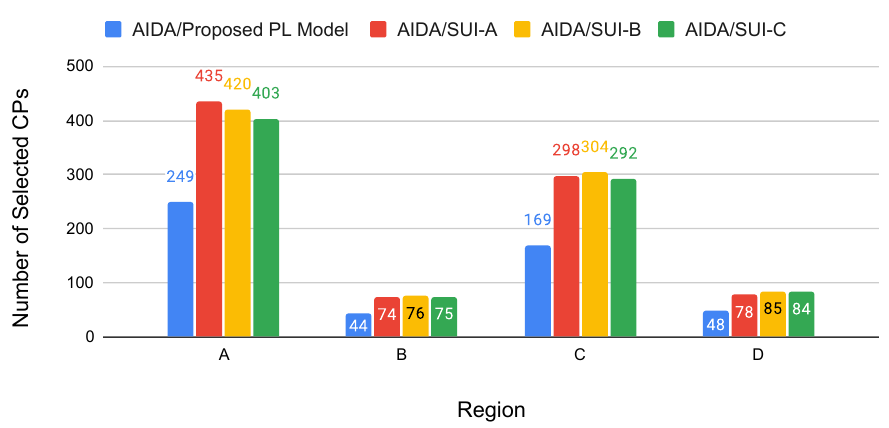
Figure 10. Number of CPs selected by the AIDA method using its original path loss model (AIDA/proposed PL model) compared to the values selected by the AIDA method using the Erceg- SUI path loss model for the terrain Category A (AIDA/SUI–A), Category B (AIDA/SUI–B), and Category C (AIDA/SUI–C). The chart compares the performance of AIDA for the Regions A, B, C, and D, used in the experiments. Table 8. AIDA (TD approach, with its proposed PL model) results compared to the results of AIDA using the Erceg-SUI path loss